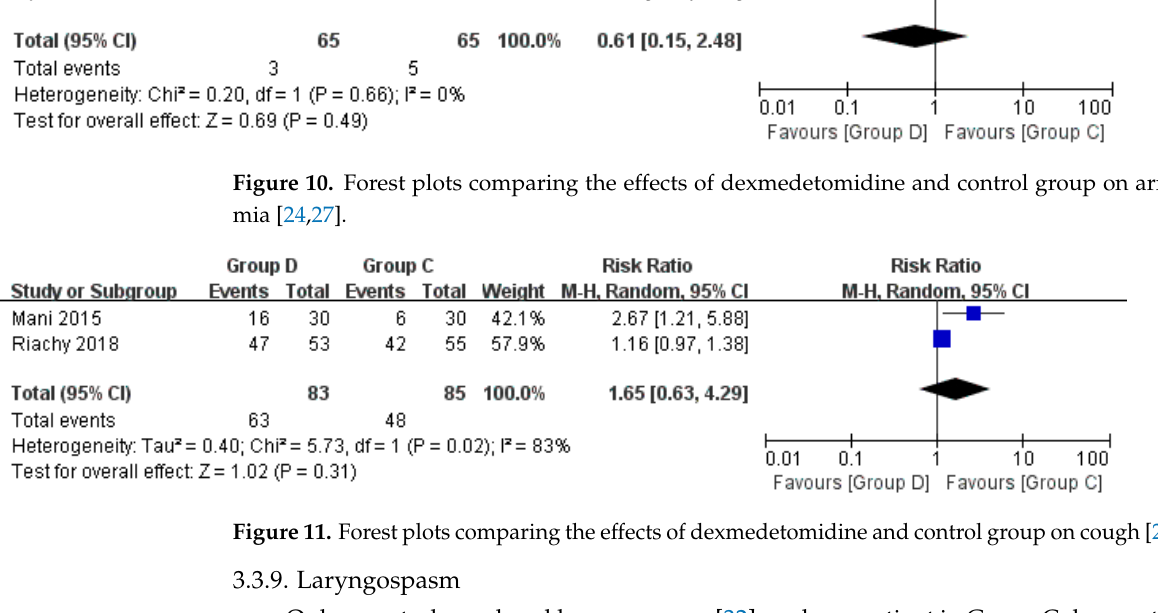
Figure 11. Forest plots comparing the effects of dexmedetomidine and control group on cough